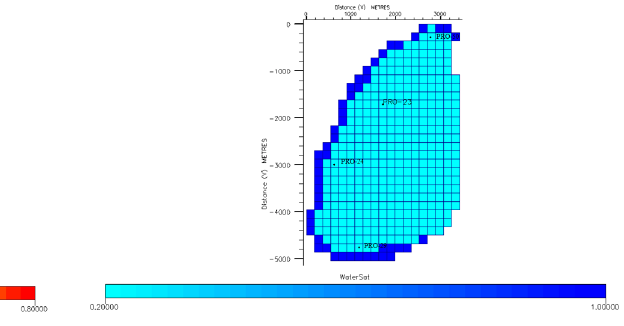
Figure 4. Description for case study 1.